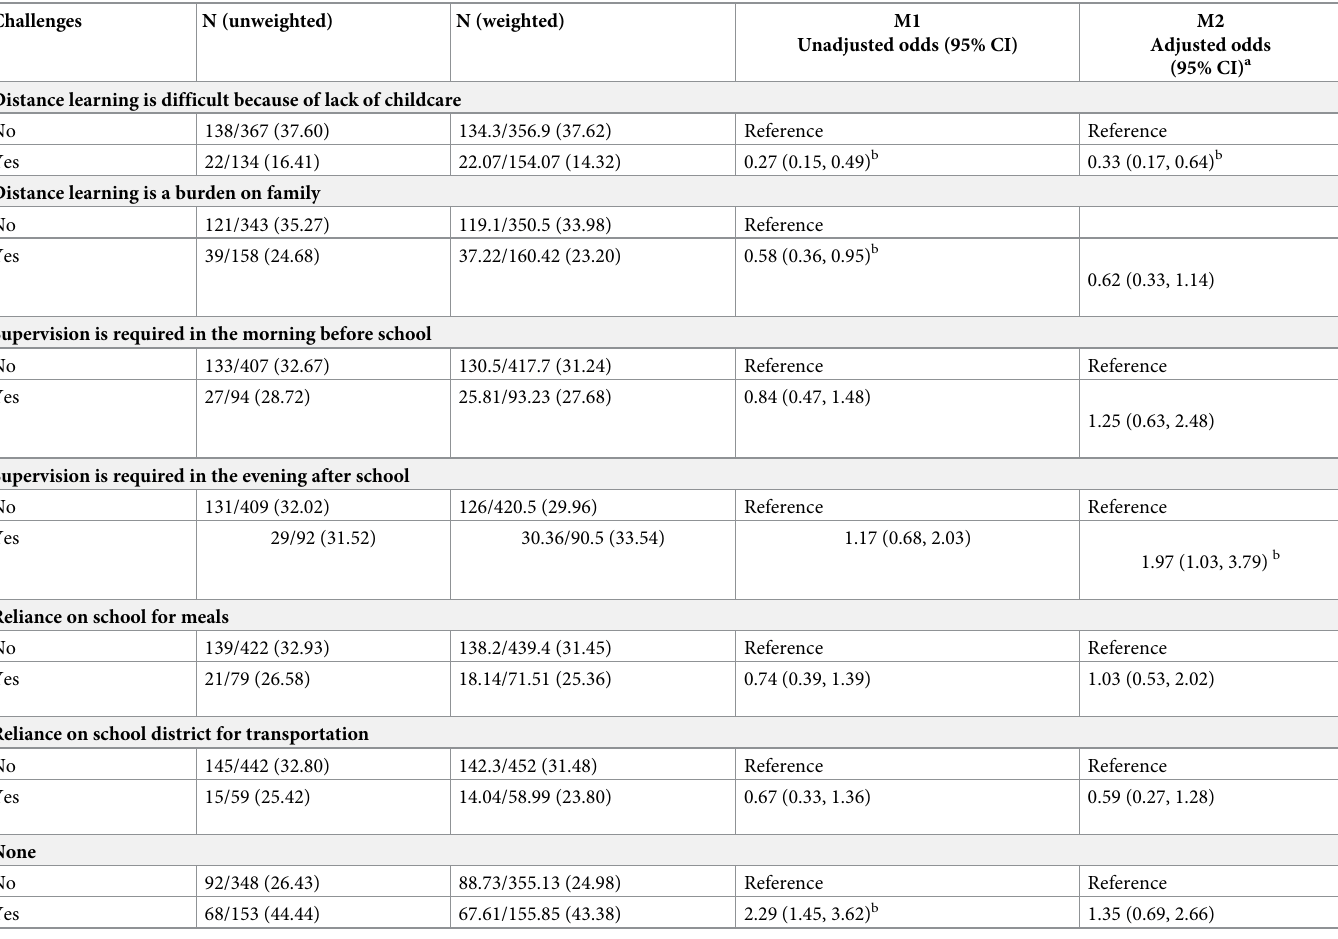
Table 3. Results from unadjusted logistic regression models (M1) compared to adjusted multivariable models (M2), including 95% confidence intervals (CI).